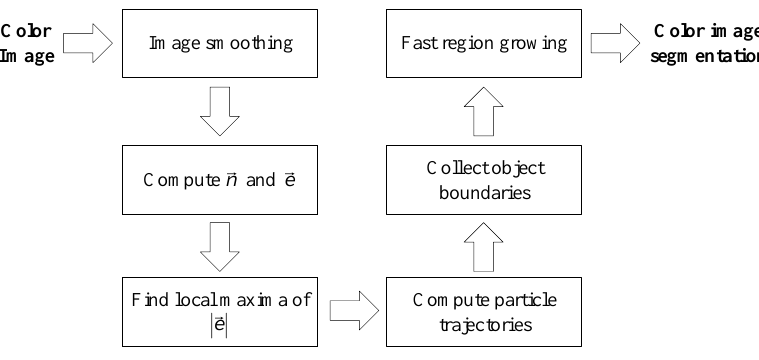
Figure 6. Block diagram of the proposed boundary extraction process.